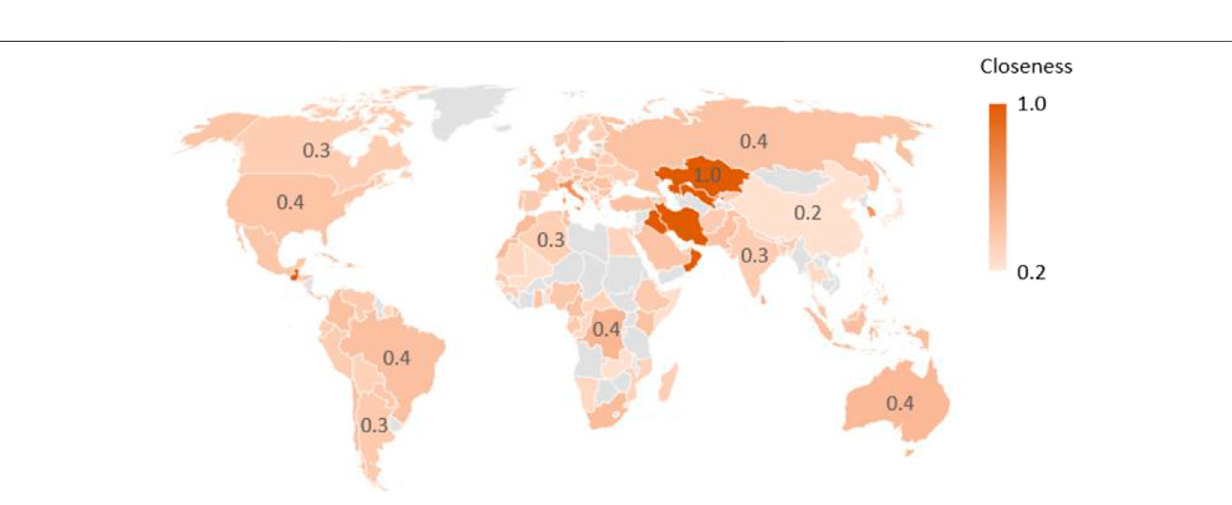
Frontiers in Physics |